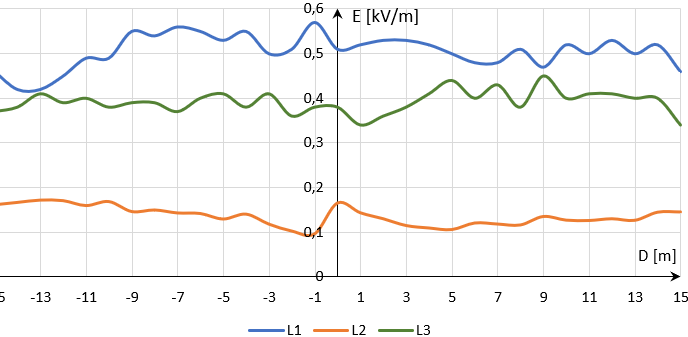
Figure 14. Distribution of electric field strength E along L1, L2, L3 phase conductors of the 15 kV container power line, ELF frequency range (measurement methodology as in Figure 2).